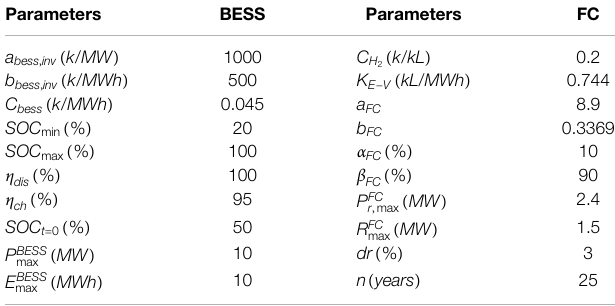
TABLE 2 | Parameters of diesel BESS and FC